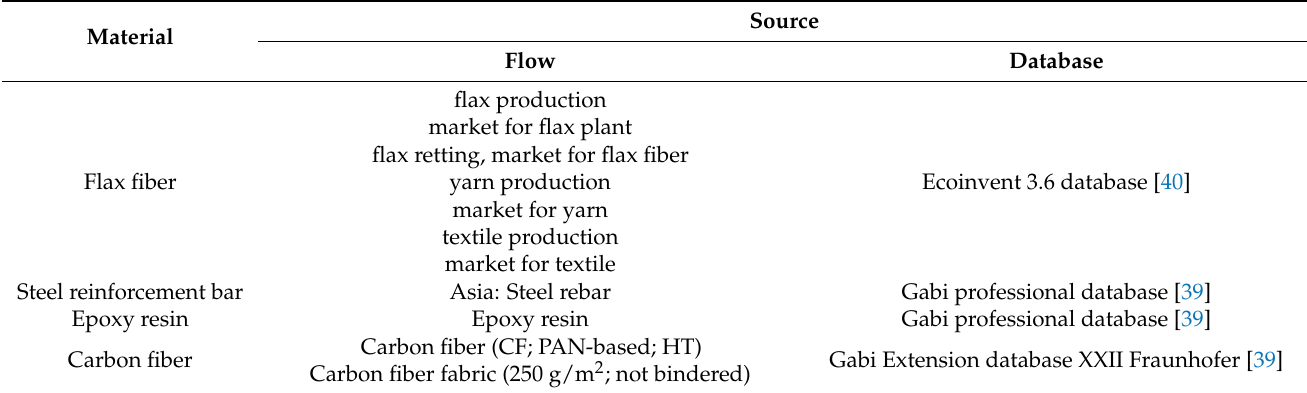
Table 6 lists the life cycle inventory—or the source of background data—in the LCA; two main sources are the databases in Gabi Professional Software [39] and input data from Ecoinvent [37,40]. The Ecoinvent database was mainly used for the LCI of natural FRP, including flows of flax cultivation, flax fiber retting, jute yarning, and jute weaving. Due to the absence of data for flax yarning and flax weaving, the flows of jute yarning and jute weaving were adopted instead to represent corresponding flows of flax. The process of epoxy resin from the Gabi Professional database was adopted for the epoxy binder in carbon fiber fabric. The aggregate process of steel reinforcement bar from Gabi Extension database XXII Fraunhofer was used for the LCI of the steel stirrup in this study. Table 6. Life cycle